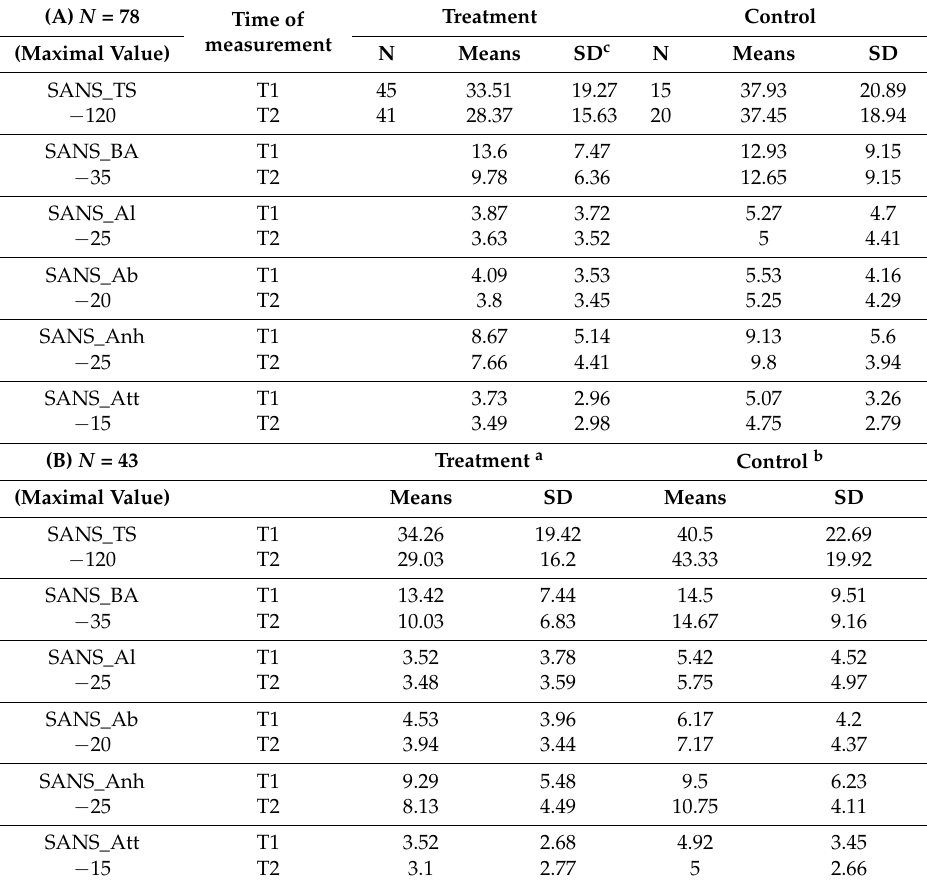
Table 2. Psychometric properties of all outcome variables for the entire sample ( A ) and the complete cases ( B